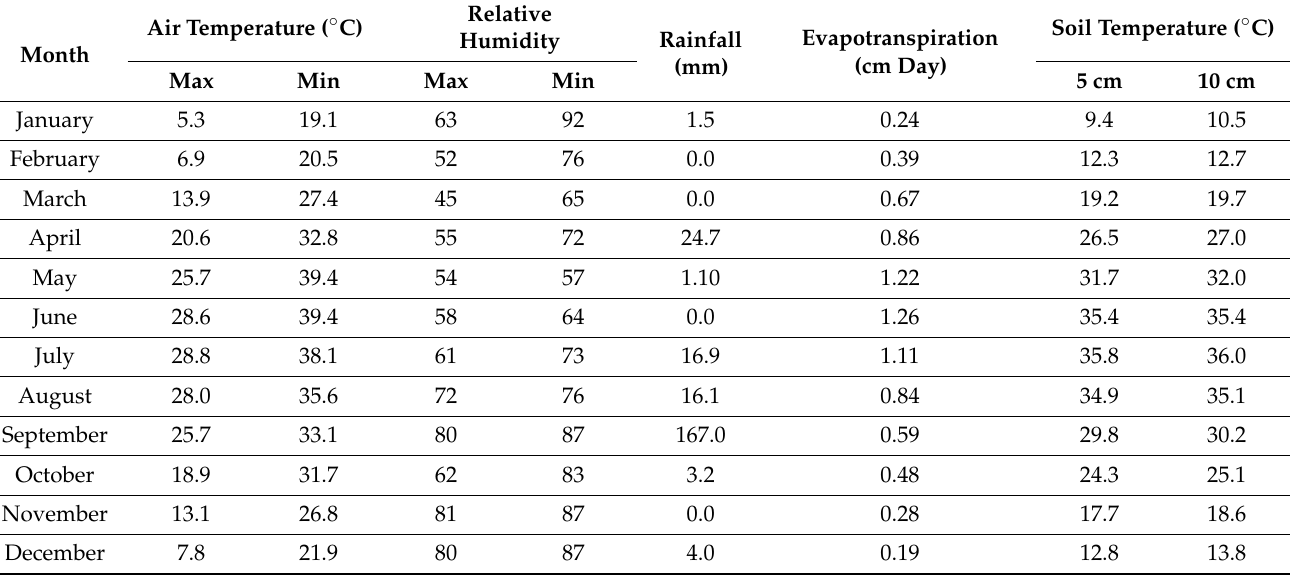
Table 1. Comparative Monthly Meteorological Data Recorded at CCRI,